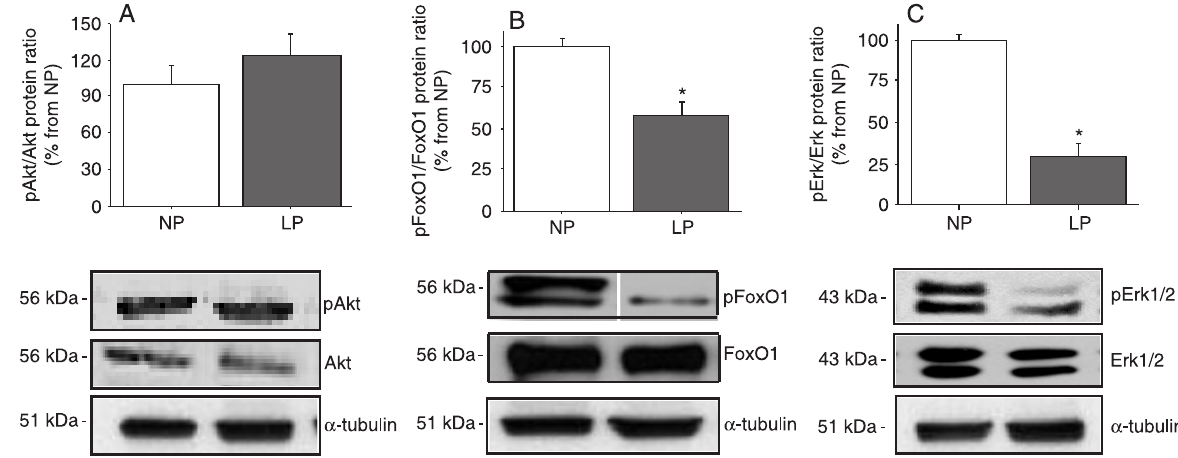
Figure 3. Protein ratio of A , phosphorylated serine-threonine protein kinase (pAkt)/Akt, of B , phosphorylated forkhead-O1 (pFoxO1)/ FoxO1, and of C , phosphorylated extracellular signal-regulated kinase 1/2 (pErk1/2)/Erk1/2 in pancreatic islets from rats receiving a normal-protein diet (NP) and a low-protein diet (LP). A representative control blot for α-tubulin is shown below each panel. Data are reported as means ± SEM for 5 independent experiments. * P < 0.05 compared to NP (Student t-